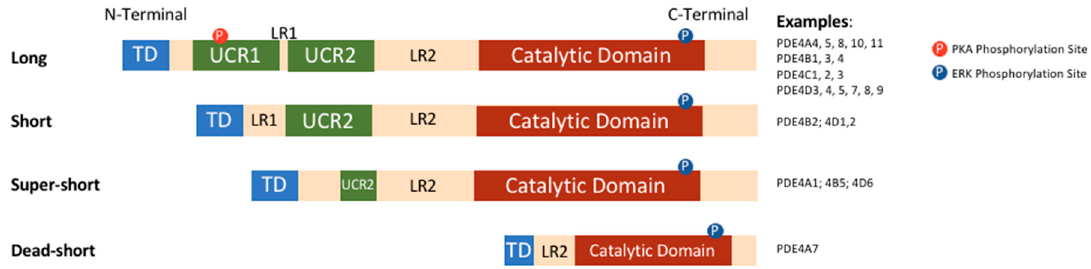
Figure 1. Diversity of domain organisation of PDE4 isoforms TD, transduction domain; LR1/2, linker region 1/2; UCR1/2, upstream conserved region 1/2.